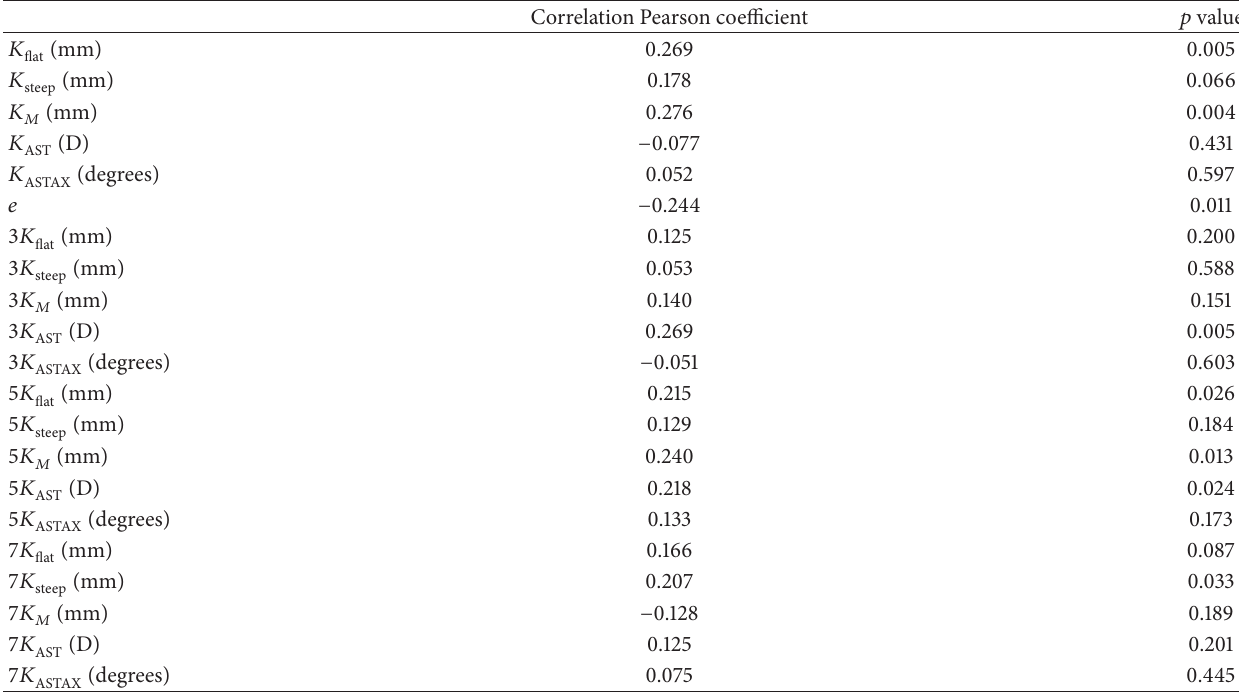
Table 4: Summary of correlations between different corneal power and eccentricity parameters and their within-subject standard deviation ( 𝑆 𝑤 ) associated.